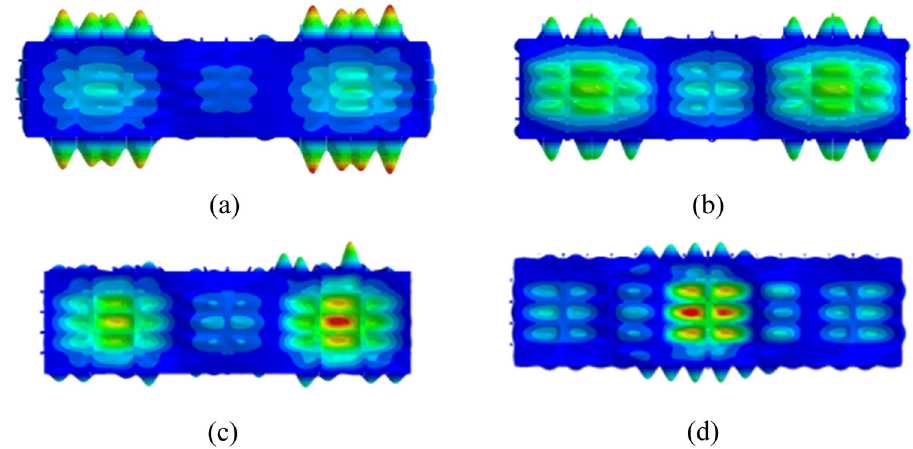
Figure 9: Modal results of multicabin panels ( without struts ) : ( a ) 46.6 Hz, ( b ) 55.2 Hz, ( c ) 64.7 Hz, and ( d ) 82.9 Hz.